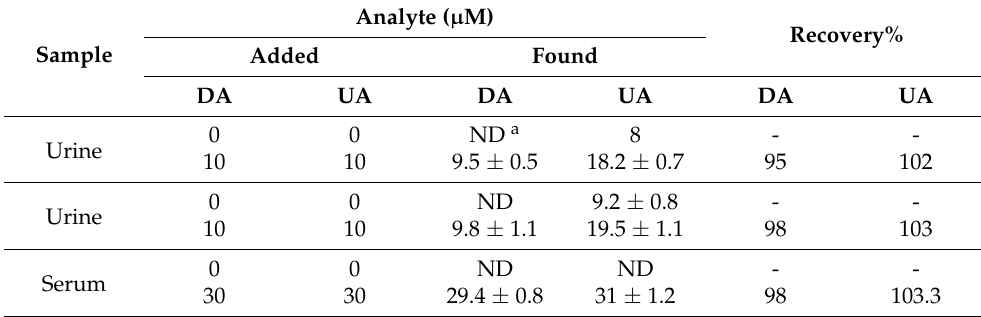
Table 4. The obtained recovery values of DA and UA in urine and serum samples.